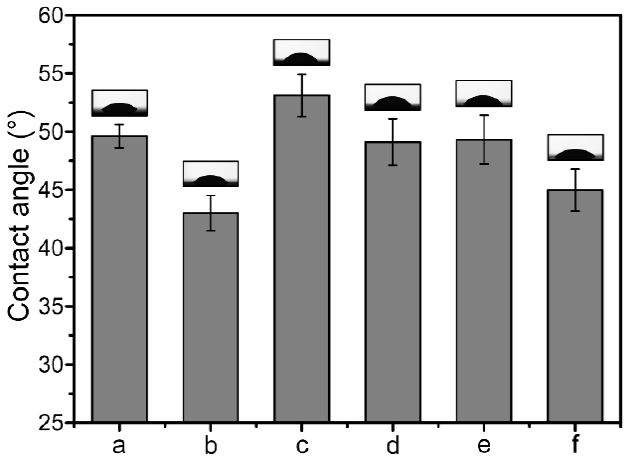
Figure 6. Contact angle values and bars of drug-loaded nanofibrous membranes: ( a ) CS / PVA nanofibrous membrane, ( b ) CS / PVA / GO nanofibrous membrane, ( c ) CS / PVA / CipHcl nanofibrous membrane, ( d ) CS / PVA / GO / CipHcl nanofibrous membrane, ( e ) CS / PVA / Cip nanofibrous membrane, ( f ) CS / PVA / GO / Cip nanofibrous membrane. Inset: water drop images for each membrane surface.